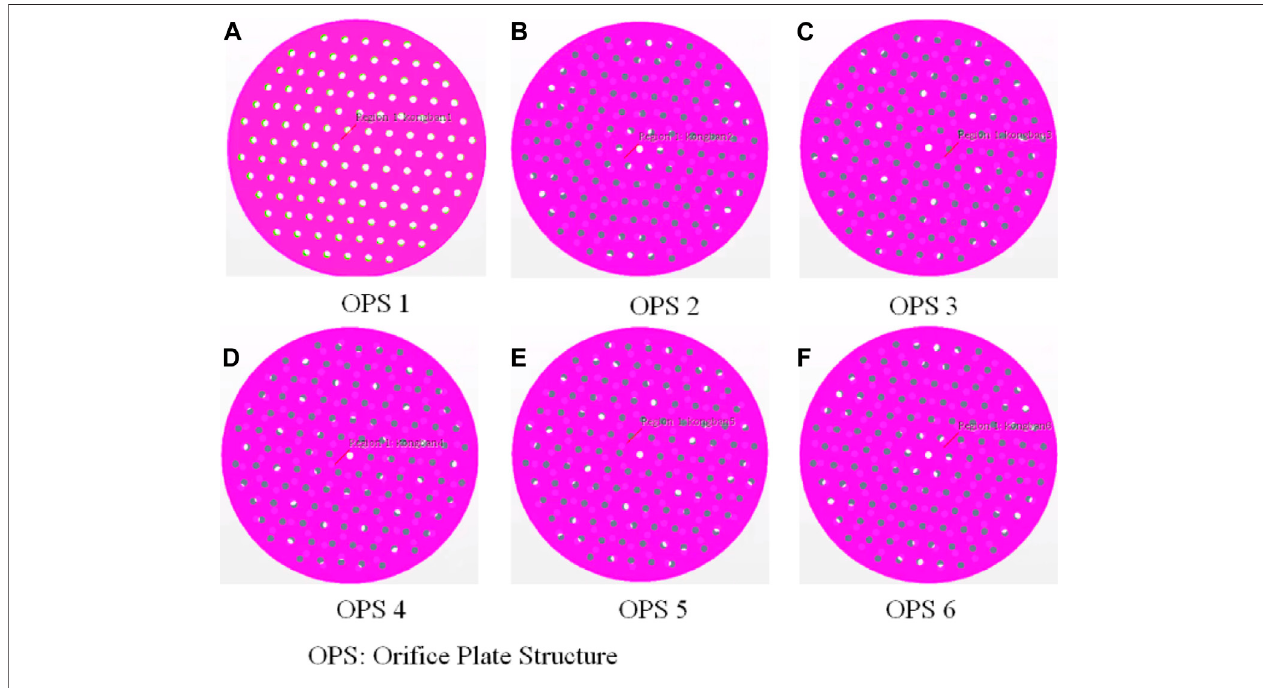
FIGURE 5 | The models of six ori fi ce plate structures.